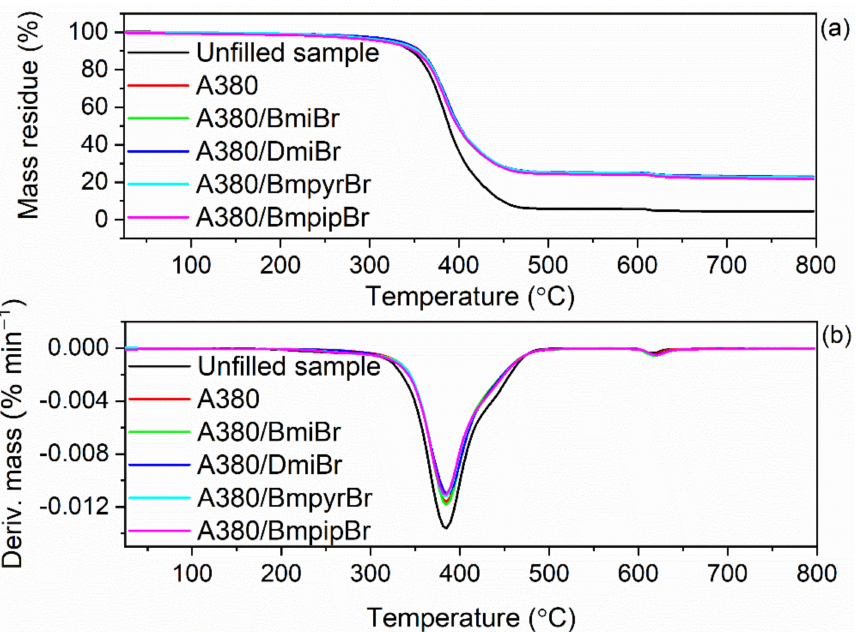
Figure 9. Thermogravimetric (TG) and derivative thermogravimetric (DTG) curves of the silica-filled NR vulcanizates containing ILs with bromide anion: ( a ) TG curves; ( b ) DTG curves.